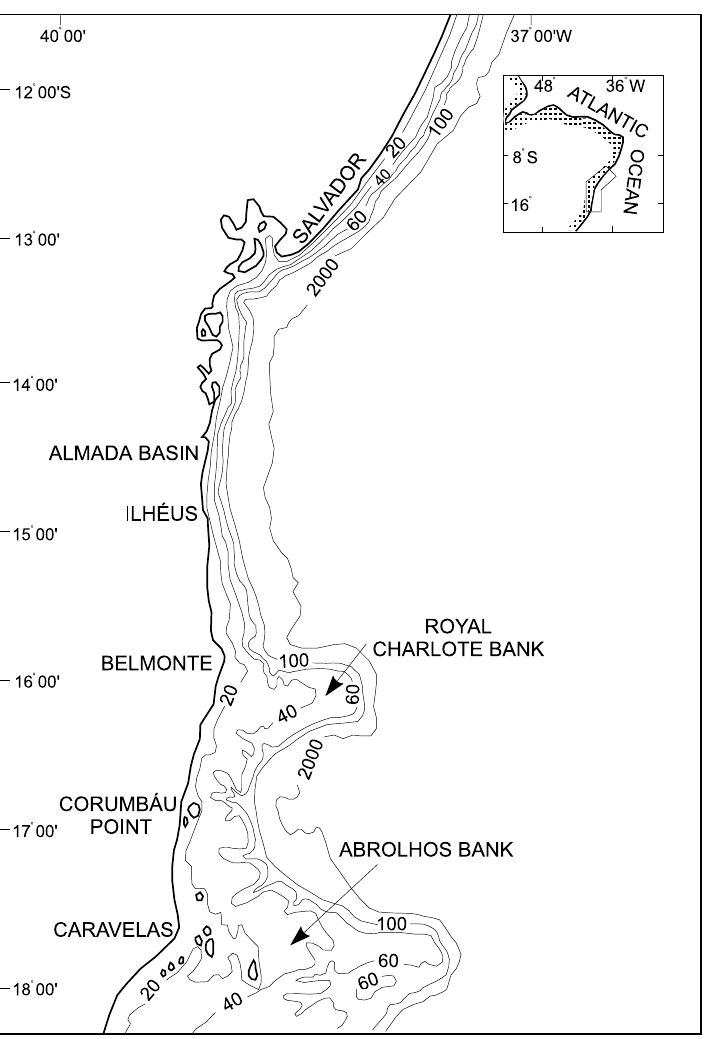
Fig. 1 – Physiographic aspects of the continental shelf of the State of Bahia. Bathymetric contours in